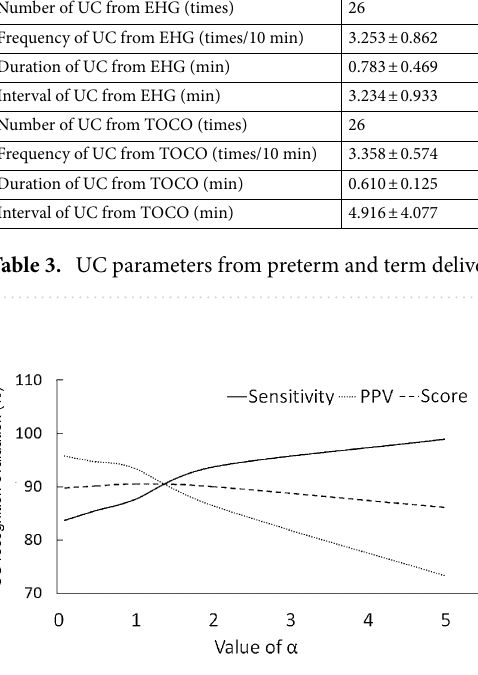
Figure 1. The influence of α on the recognition result.